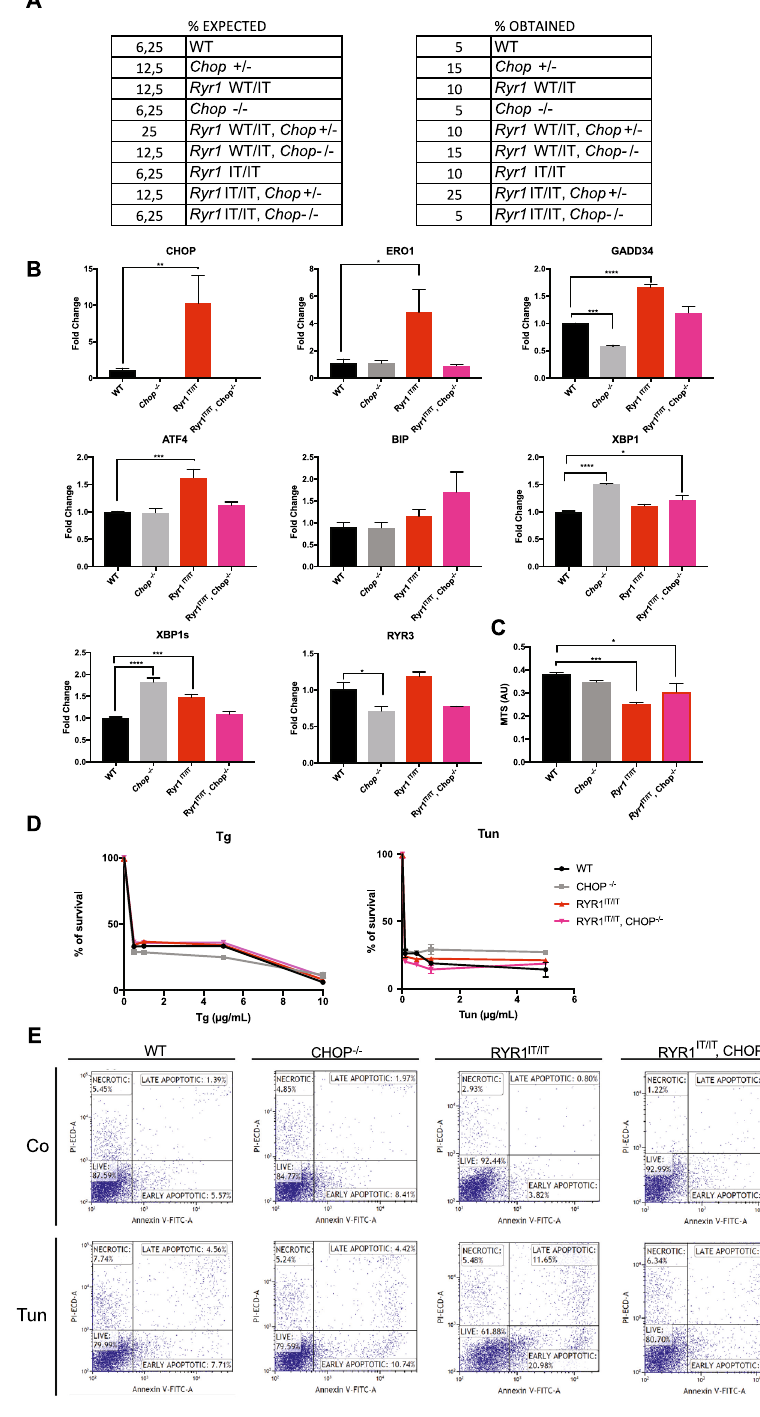
Figure 3. Effect of CHOP deletion on ER stress levels and the viability of Ryr1 I4895T/I4895T cells. ( A ) The expected and observed distribution of twenty embryos on E13.5 as a percentage of the different genotypes obtained from a cross between Ryr1 WT /I4895T , Chop + /− trans-heterozygote female and male mice. ( B ) Semi-quantitative real-time RT-PCR of ER stress/ER stress response markers (and Ryr3) from mRNA prepared from MEFs of the indicated genotypes ( N = 4). ( C ) Bar graphs presenting the growth rate (MTS) in 24 h of an equal number of cells with the indicated genotypes ( N = 5). ( D ) Survival of MEFs that received no treatment or were treated with the indicated concentrations of thapsigargin (Tg) and tunicamycin (Tun) for 24 h. Survival is expressed as the relative amount of MTS signal reduced by thapsigargin- and tunicamycin-exposed cells compared with unexposed cells (arbitrarily set to 100%) ( N = 5). ( E ) Apoptosis analysis. Cells treated with or without tunicamycin (1μg/ mL) were analyzed for Annexin-V and propidium iodide (PI) by flow cytometry and divided into necrotic, late apoptotic, early apoptotic and live